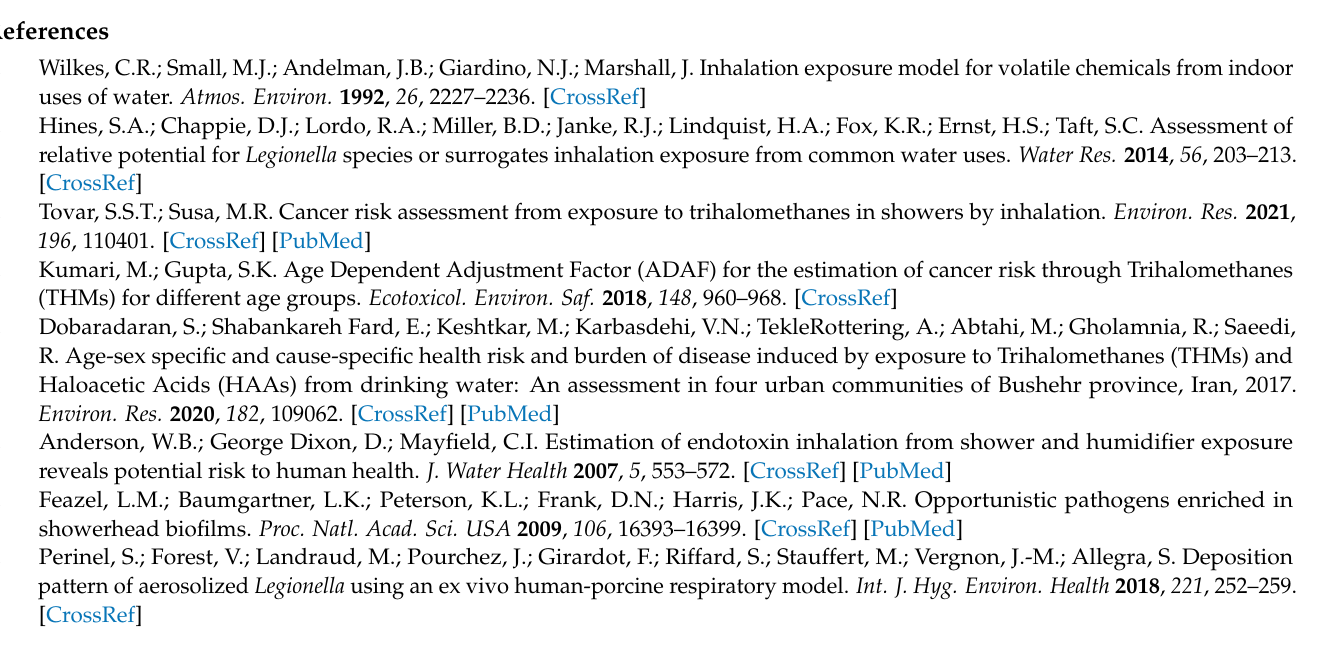
Figure A1. Distribution of inhalable water droplets in the shower volume: ( a ) during the radial movement of the sampler; ( b ) during the vertical movement of the sampler.